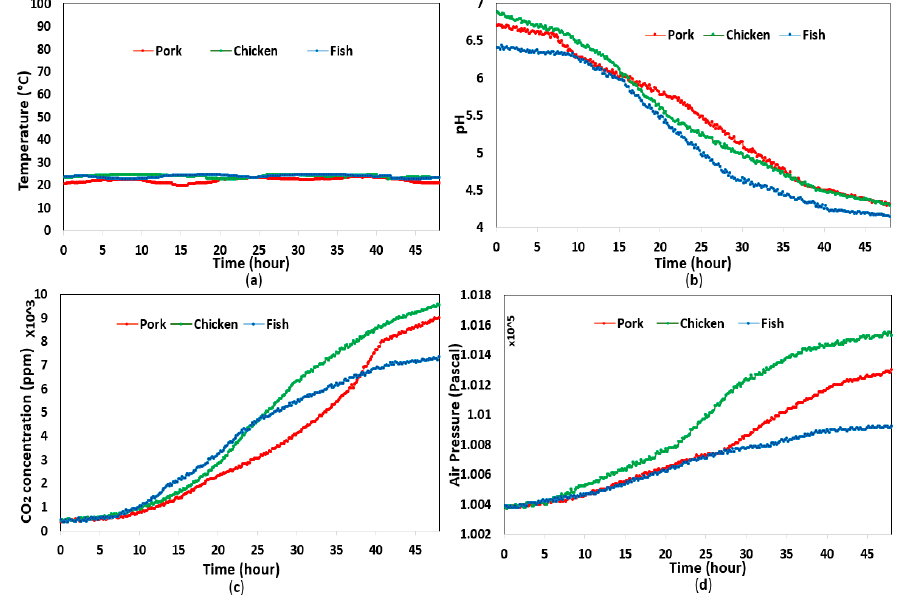
Figure 3. Experimental results with food at room temperature for 2 days: ( a ) temperature; ( b ) pH; ( c ) CO 2 concentration; ( d ) headspace pressure.